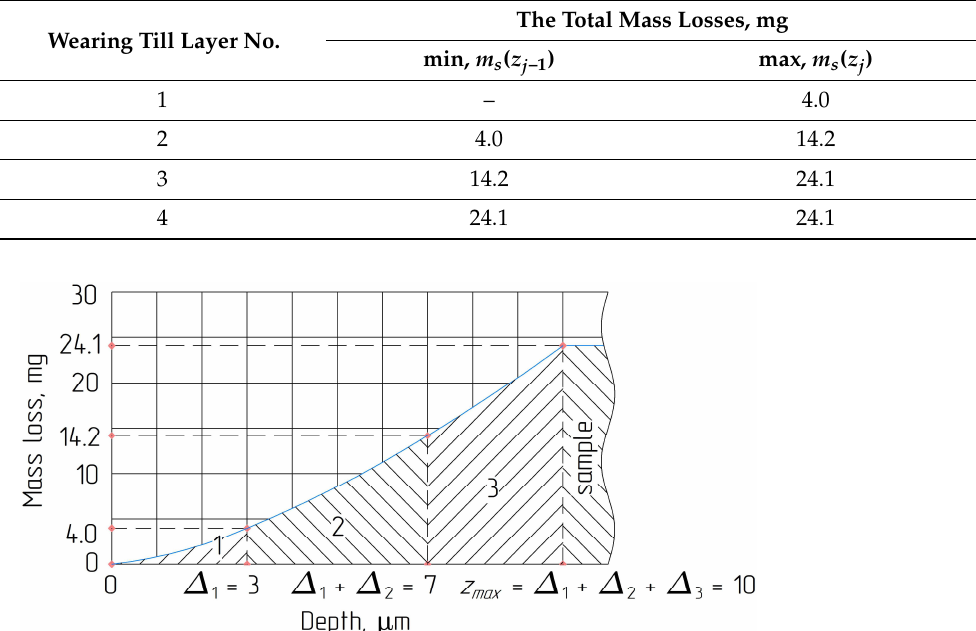
Table 2. Mass loss ranges.